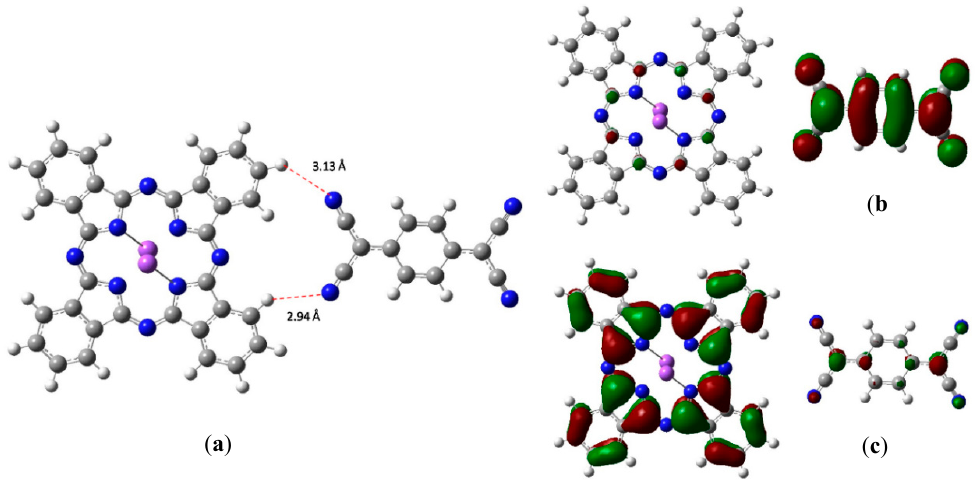
Figure 2. Optimized structures of Na 2 Pc + tetracyano- π -quinodimethane (TCNQ): ( a ) Hydrogen bonds, ( b ) lowest energy unoccupied molecular orbital (LUMO), and ( c ) highest energy occupied molecular orbital (HOMO).